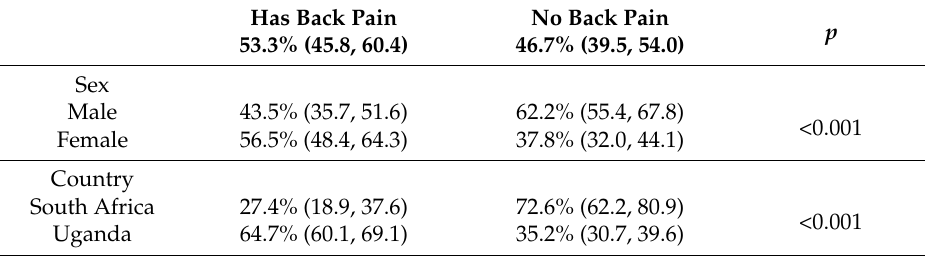
Table 3. Prevalence of back pain among older men and women in South Africa and